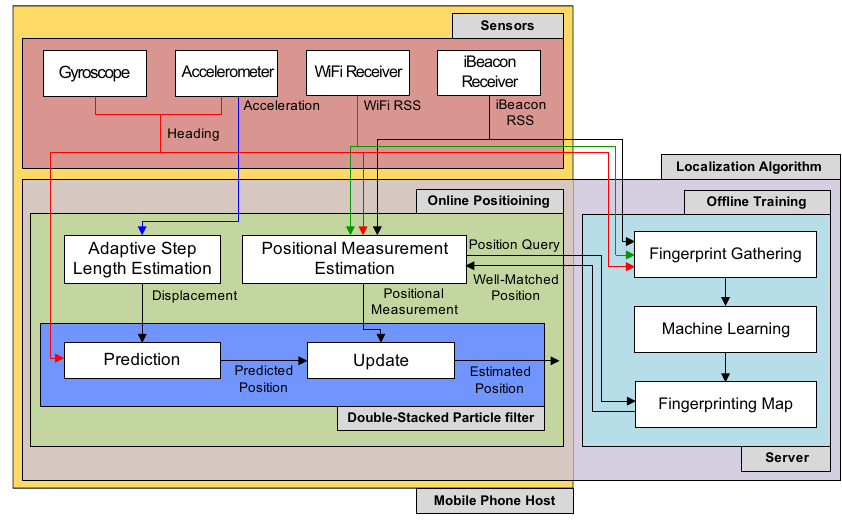
Figure 1. Localization system